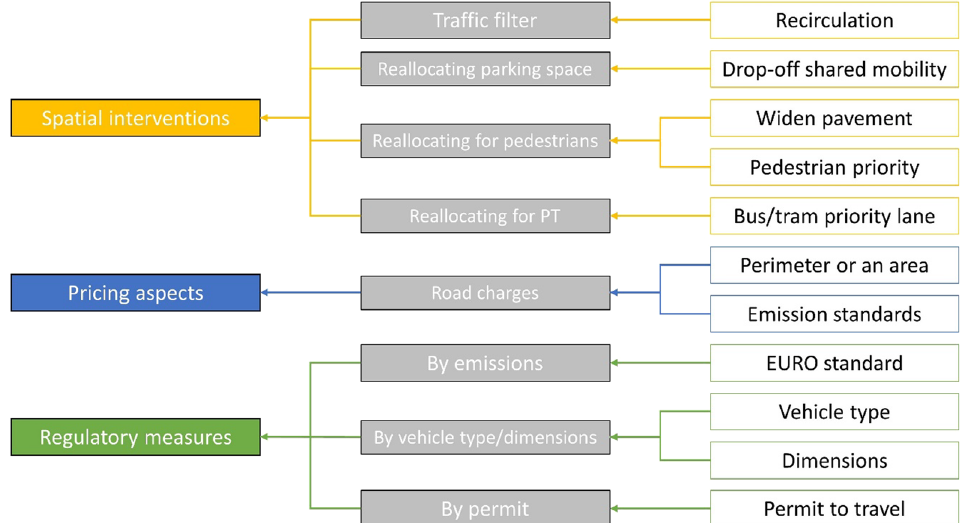
Fig. 12 Schematic representation of the UVAR taxonomy applied for the case study of Greater London (implementation of a pollution